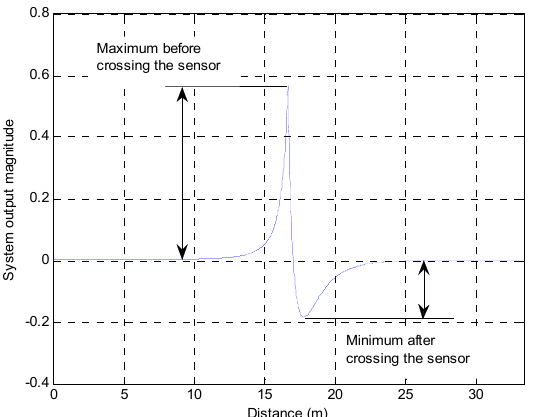
Figure 5. Performance criterion (maximum and minimum) of the PVVE